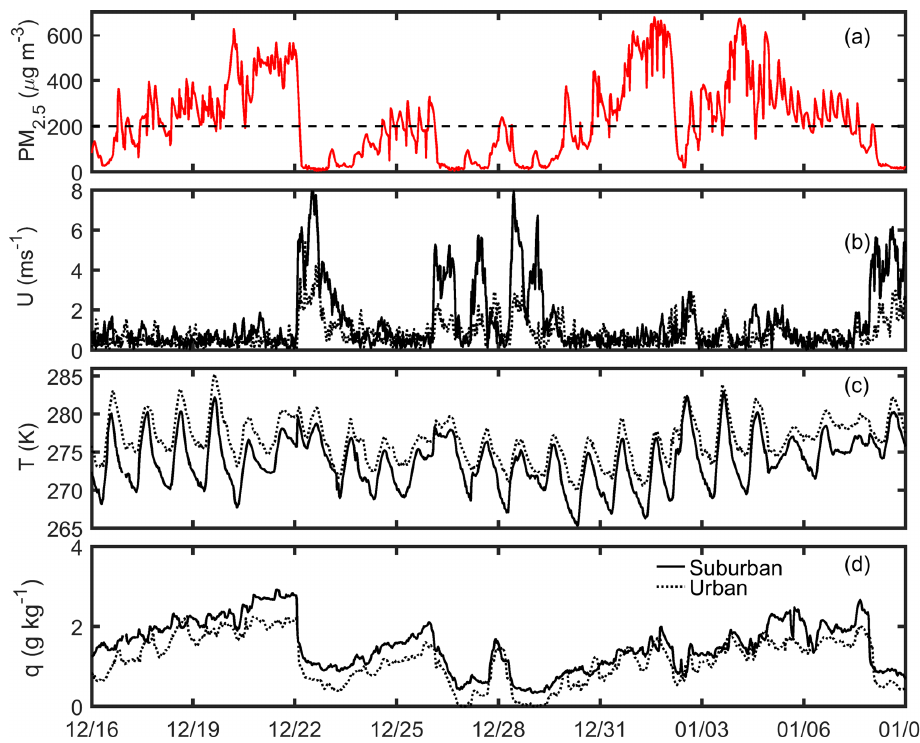
Figure 2. The PM 2 . 5 mass concentration (a) , horizontal wind speed (b) , virtual temperature (c) , and water-vapour mixing ratio (d) from 16 December 2016 to 8 January 2017. The black solid line represents data from the suburbs of Beijing (flat terrain), and the black dotted line represents data from the Peking University site (urban